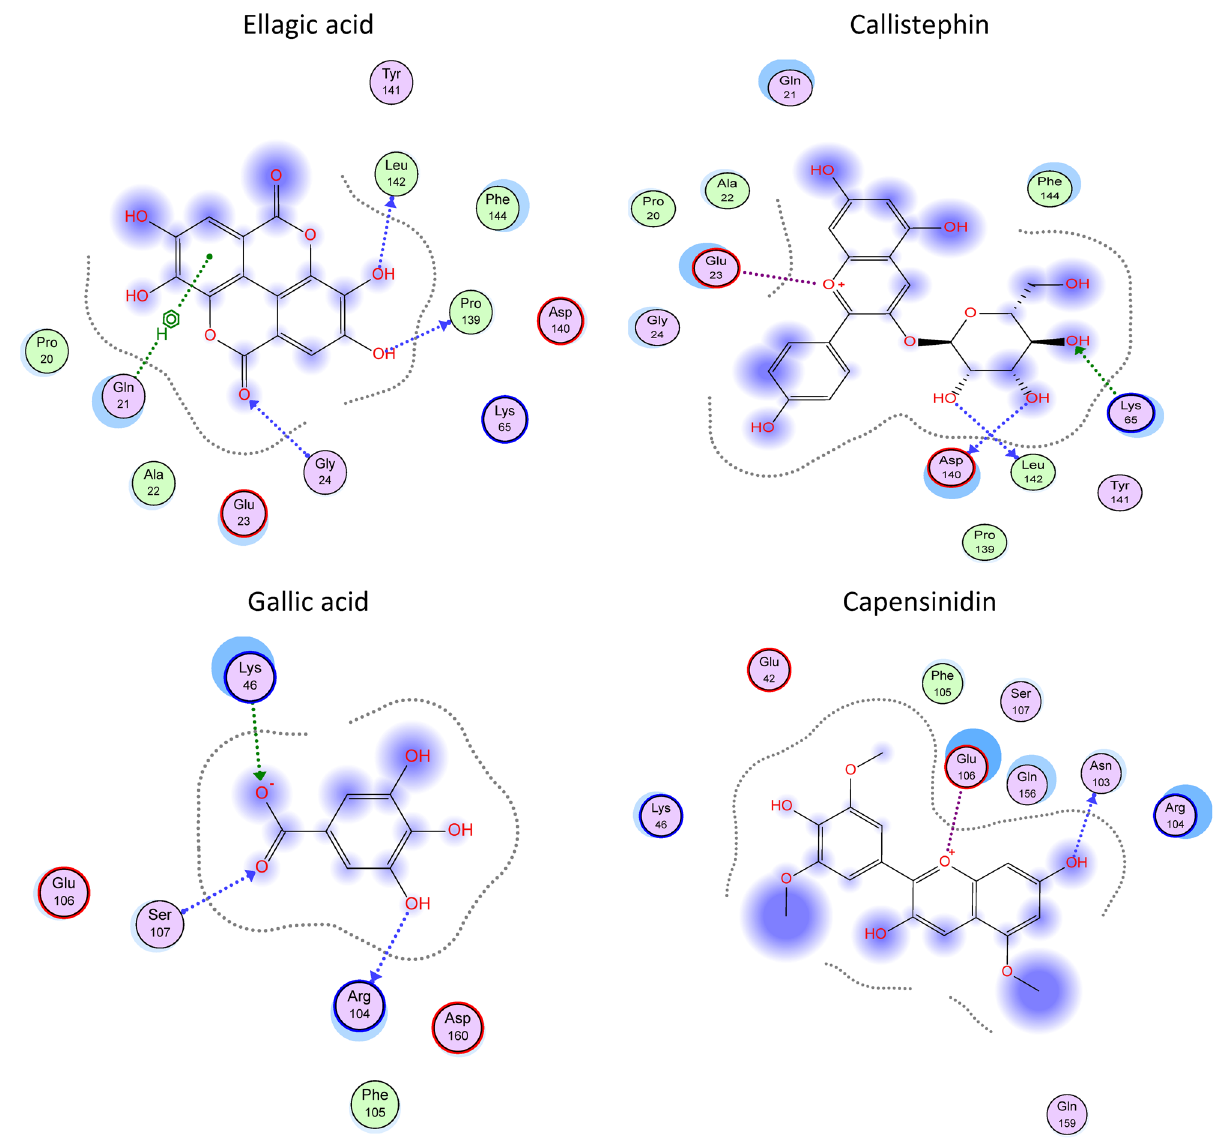
Figure 2. 2D representative of selected secondary metabolites of P. indica and P. auriculata in TNF-α and IL-6 active sites using in silico